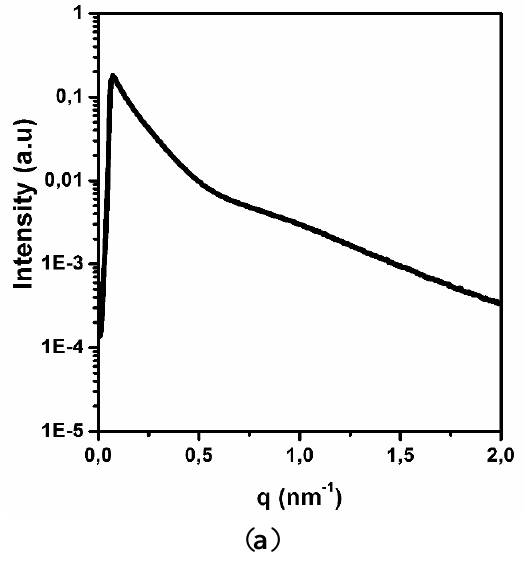
Figure 1. SAXS spectrum of the ( a ) carbon nanotubes and ( b ) their numerical analysis, used to determine the average carbon nanotube